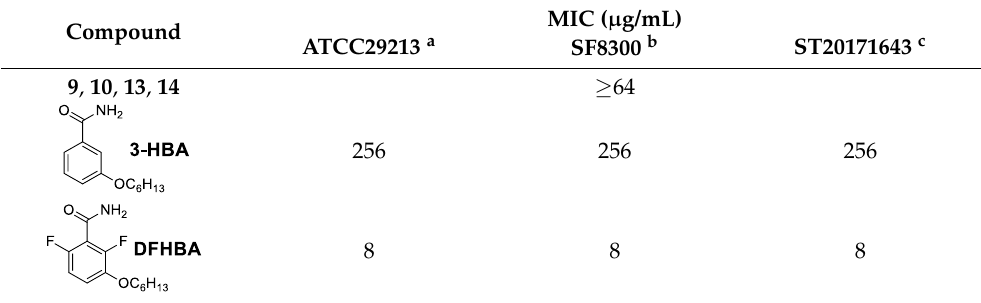
Table 1. Minimum inhibitory concentrations of benzamides and analogues against S. aureus strains. Compound